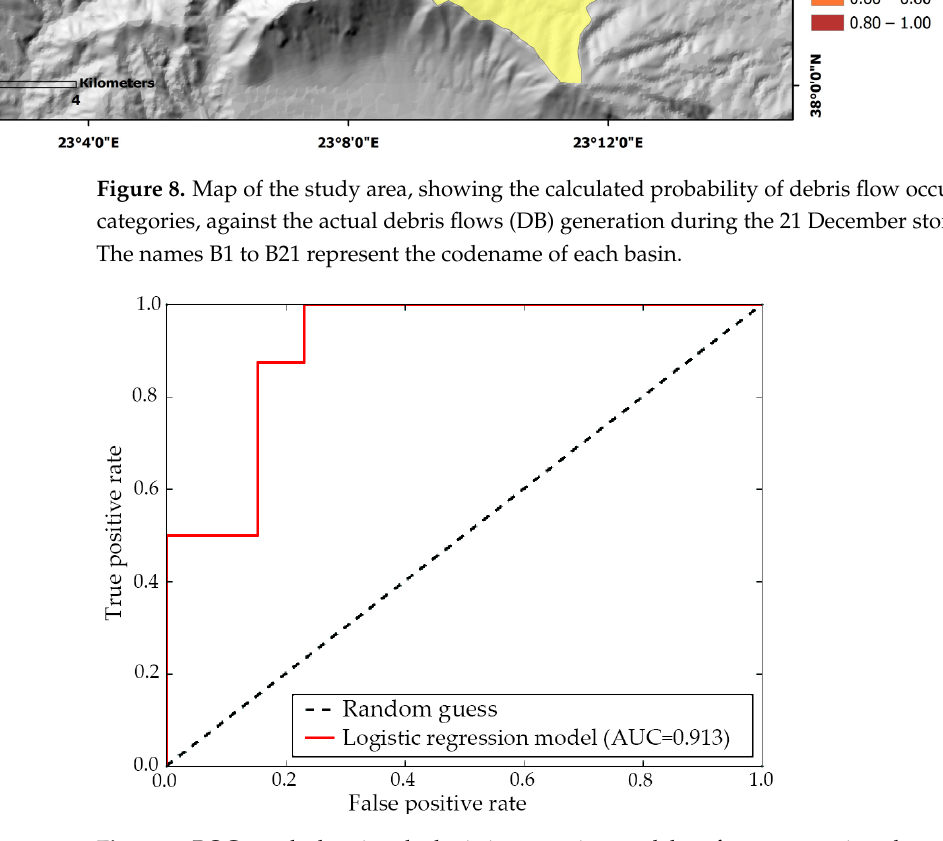
Figure 9. ROC graph showing the logistic regression model performance against the true positives of debris flow actual occurrence locations in the study area. AUC (Area Under the Curve) equals